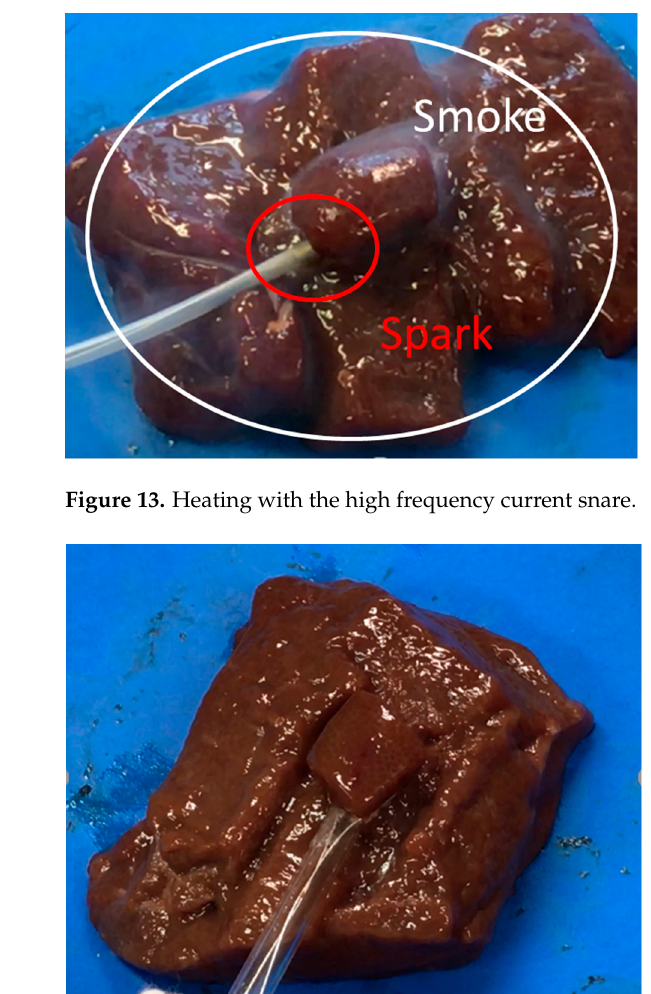
Figure 12. Liver tissue surface after the experiment.